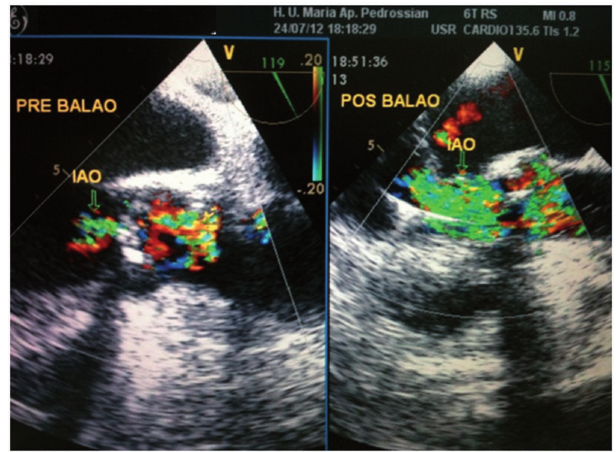
Fig. 4 – Transesophageal echocardiography showing an increase in aortic insufficiency after a balloon valvuloplasty